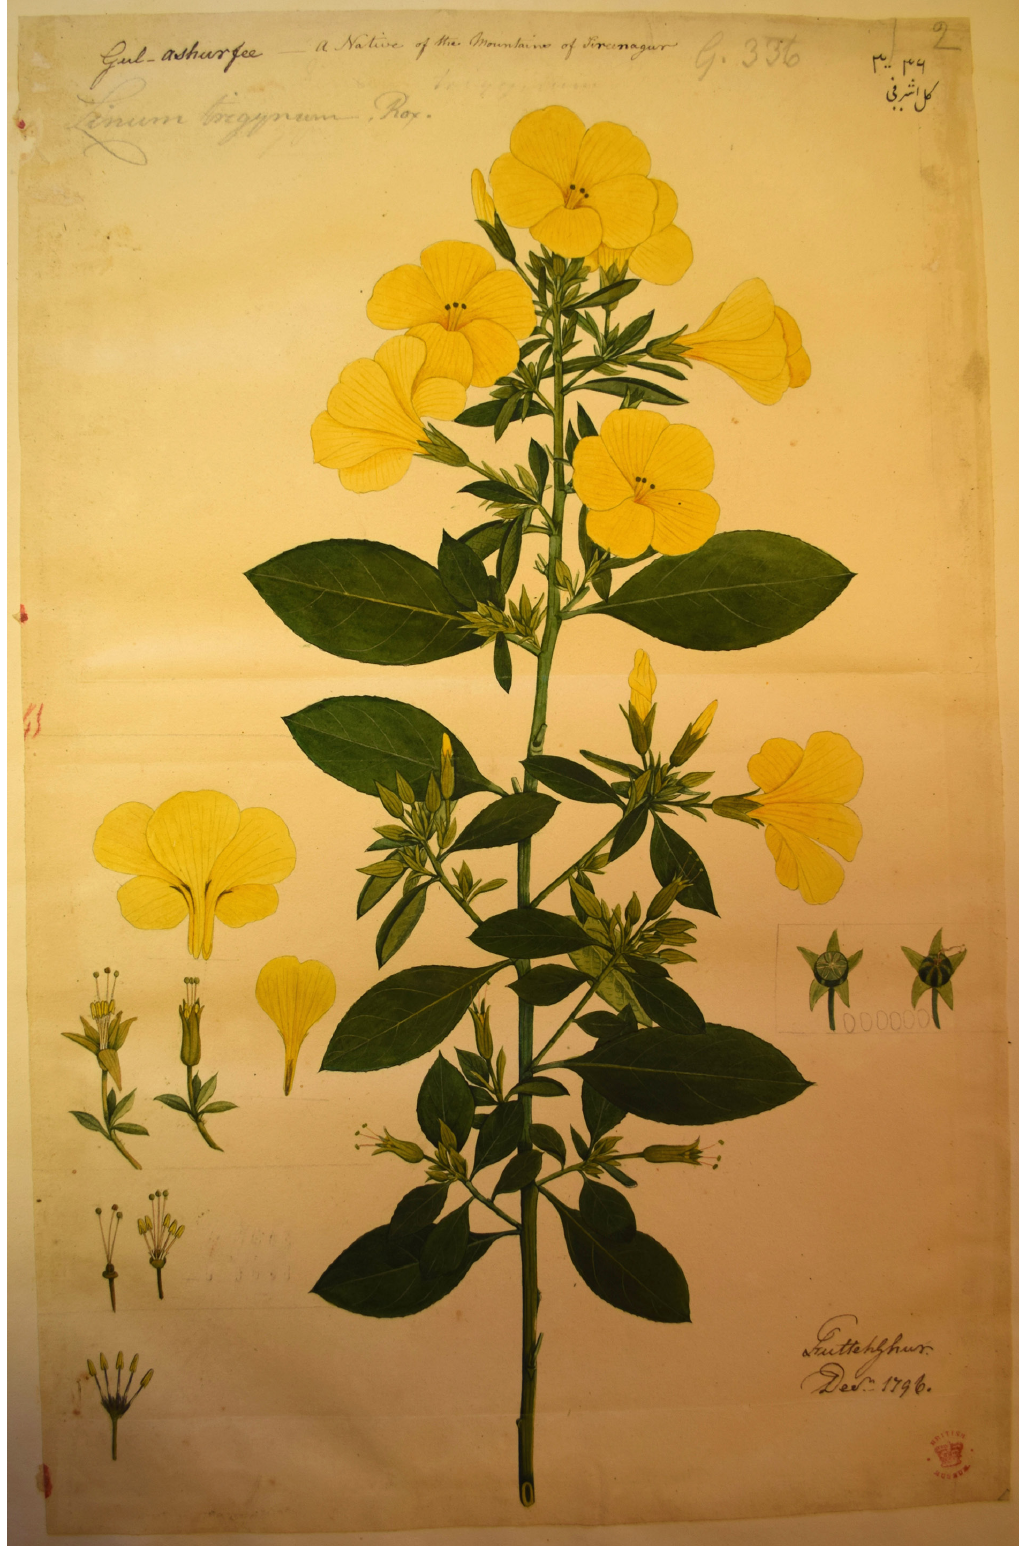
Fig. 4. Lectotype of Linum trigynum Roxb. ex Hardw., Hardwicke, Plants of India Vol. XVI (Add MS 11025): drawing no. 2. Reproduced with permission of the British Library